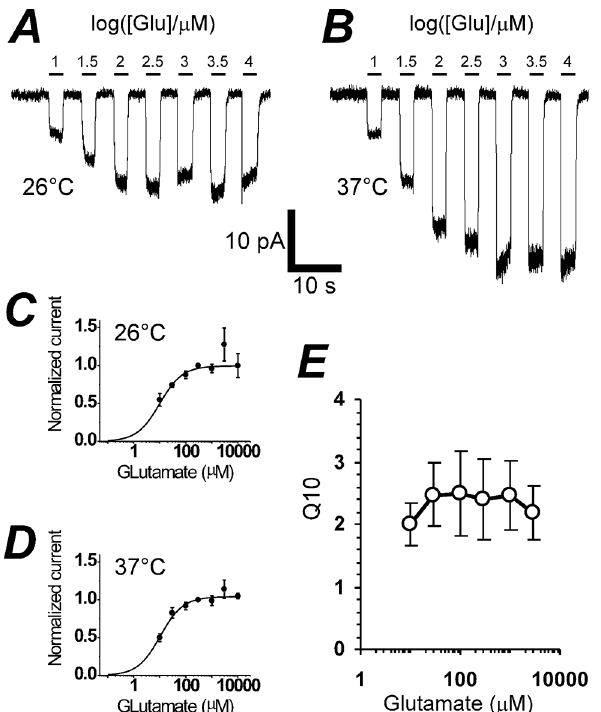
Fig 6. In the absence of chloride, Q 10 of GLT-1a does not depend on glutamate concentration. (A) Representative experiment shows responses of GLT-1a stoichiometric current to wide range of glutamate concentrations (from 10 to 10 4 μ M) at 26°C. (B) Glutamate responses of the same cell as in (A) at 37°C. The scaling bars are the same for (A) and (B) . (C) and (D) show cumulative data for 26°C and 37°C with glutamate k D,26°C = 9.9 ± 1.6 μ M and k D,37°C = 10.3 ± 1.5 μ M, respectively. ( E ) Glutamate dose dependence of Q 10 of GLT-1a. The average value of Q 10 for glutamate concentrations in the range from 30 μ M to 10 mM is 2.4 ± 0.1.